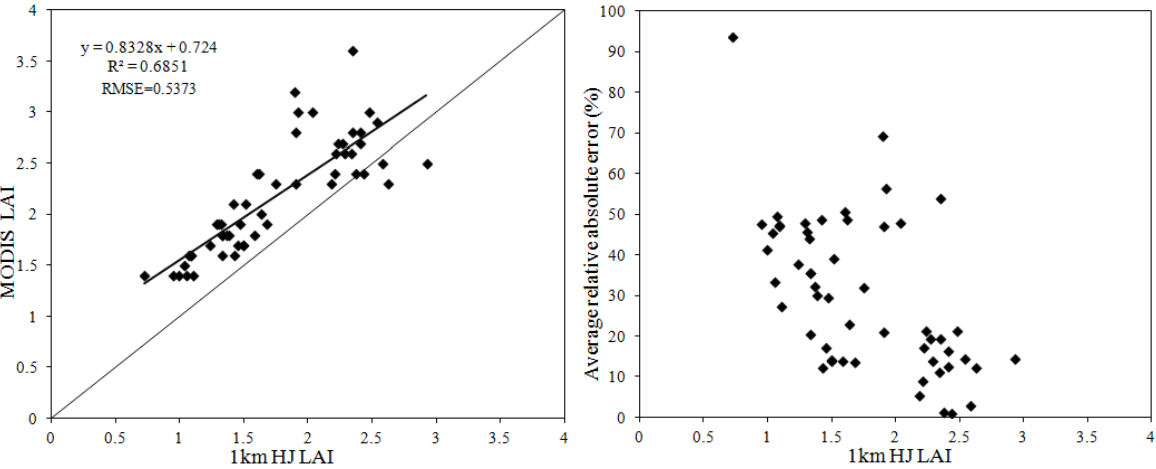
Figure 8. Pixel-by-pixel correlation between the MODIS and aggregated HJ LAI values ( left ) and the scatter-plot of the average relative absolute error with HJ LAI values ( right